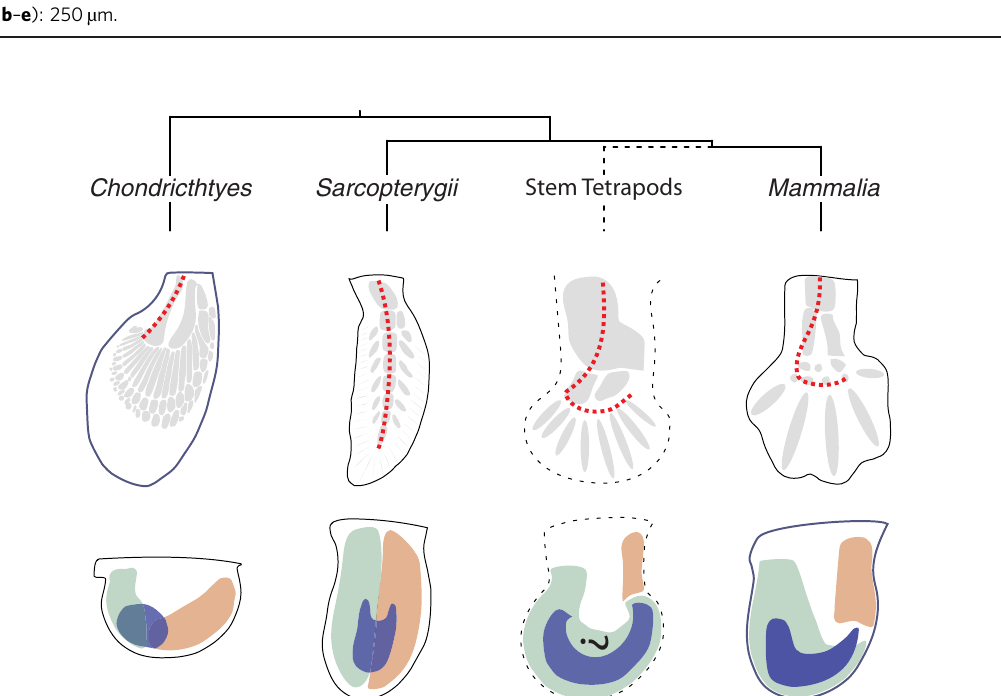
stem tetrapods ( Acanthostega ) 70 with a polydactylous autopod and distal-anteriorly bent appendage axis, the hypothetical gene expression patterns